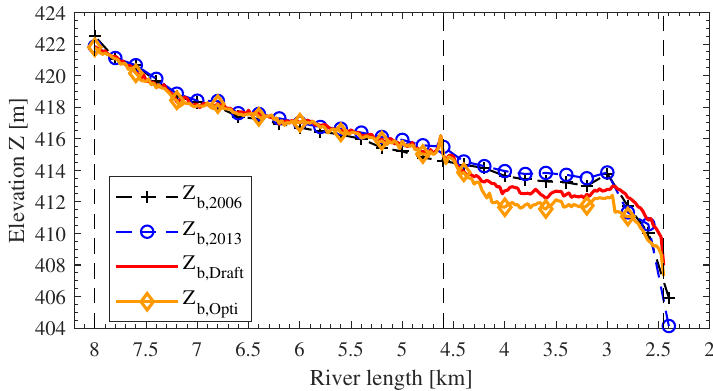
Figure 13. Longitudinal section of the riverbed levels: Observed in 2006 (Z b,2006 ) and 2013 (Z b,2013 ), as well as the result of the draft scenario (Z b,Draft ) and the simulated optimised case (Z b,Opti ).